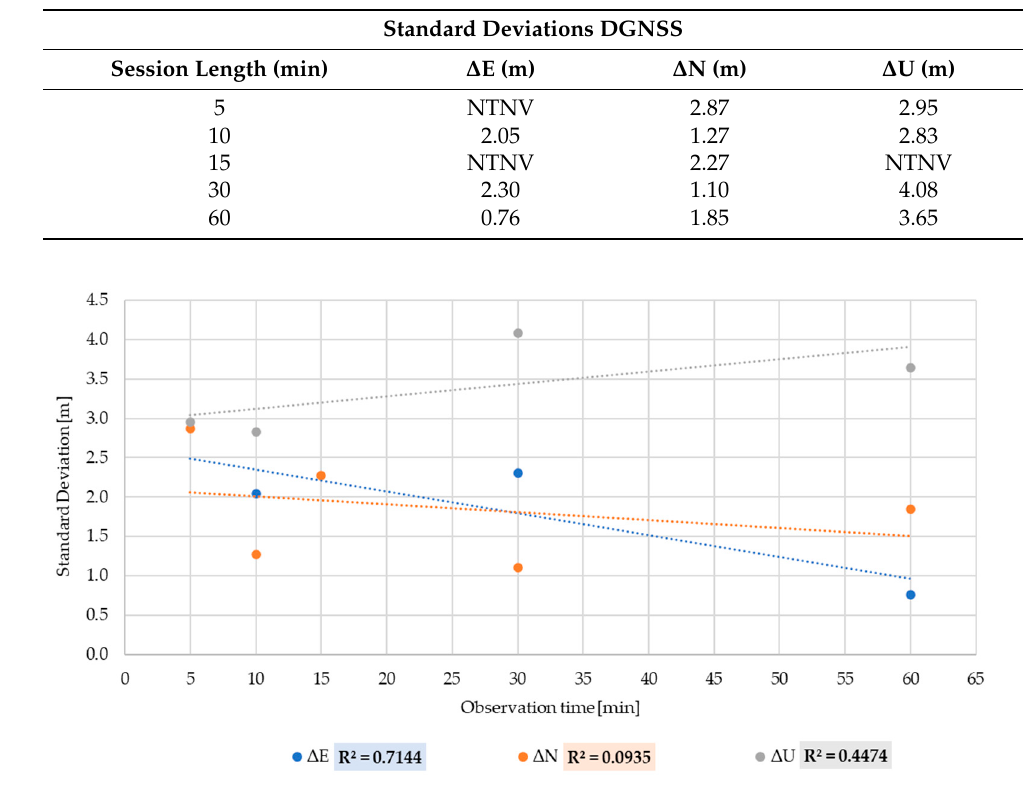
Table 5. Standard deviation values for DGNSS sub-datasets: ∆ E, ∆ N, ∆ U.